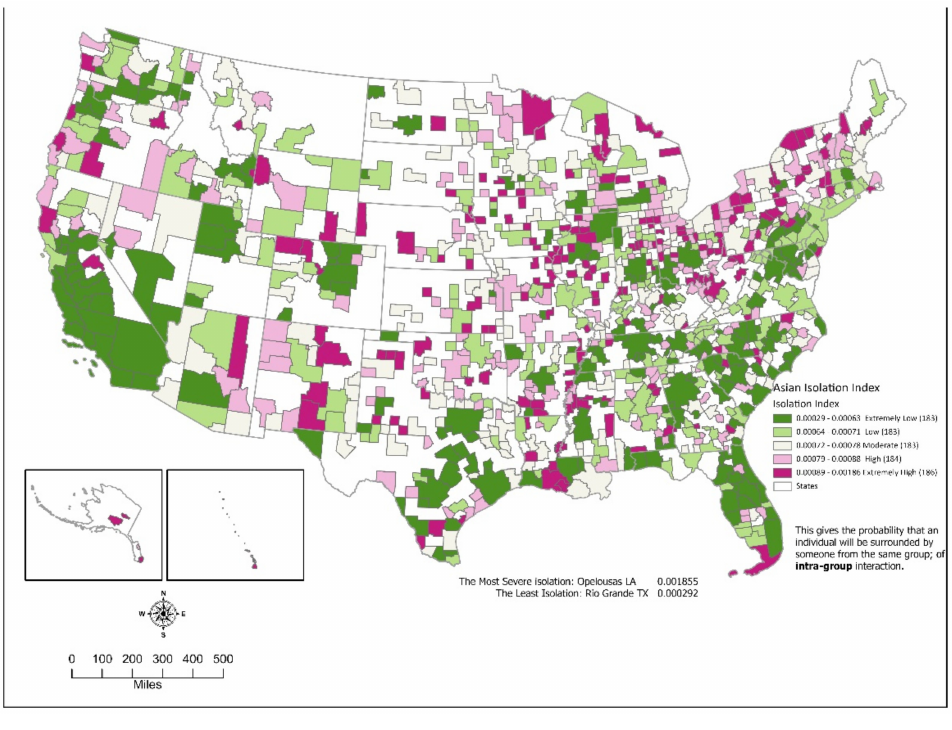
Figure 20. Asian Isolation Indices, Metro/Micro areas, 2020.